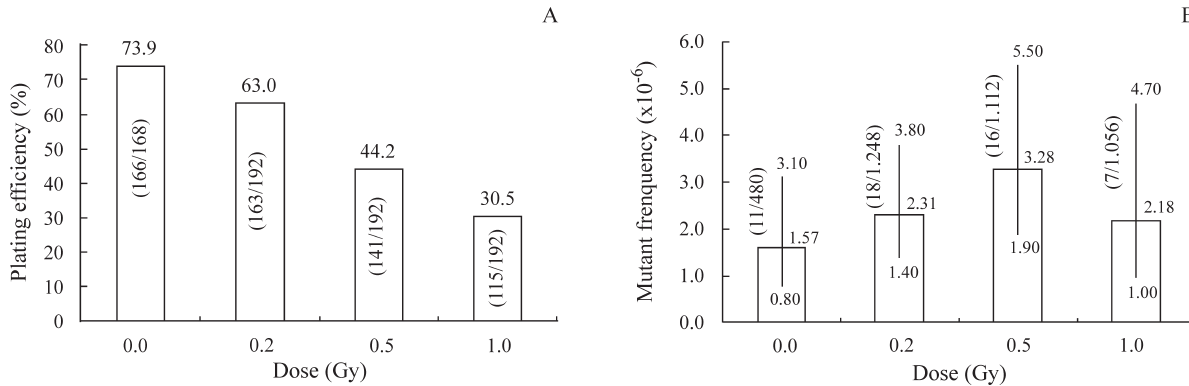
Figure 1 - Dose response of TK6 cells to ionizing radiation for (A) plating efficiencies and (B) mutant frequencies, using Poisson distribution, as de- scribedbyAlbertini etal .(2000).Errorbarsrepresentthestandarddeviationofeachmutantfrequency.Positiveclonesperwellplatedareshowninbrack- ets. (cid:4) 2 = 22.92 and 48.94 for the plating efficiencies of the groups exposed to 0.5 and 1.0 Gy, respectively. (cid:4) 2 = 110.96, 296.33, and 31.96 for the mutant frequencies of the groups exposed to 0.2, 0.5, and 1.0 Gy, respectively. p =